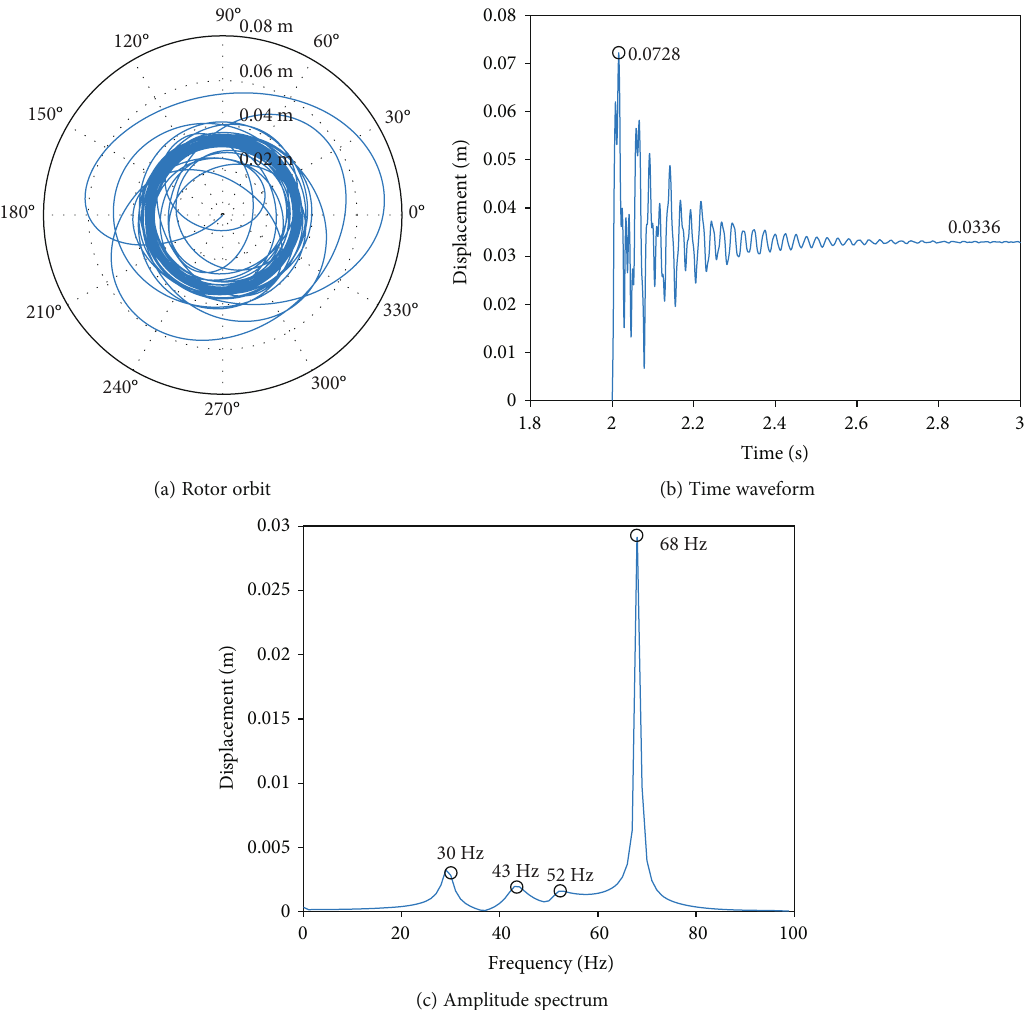
Figure 8: Response of a fan disk of a dual-rotor